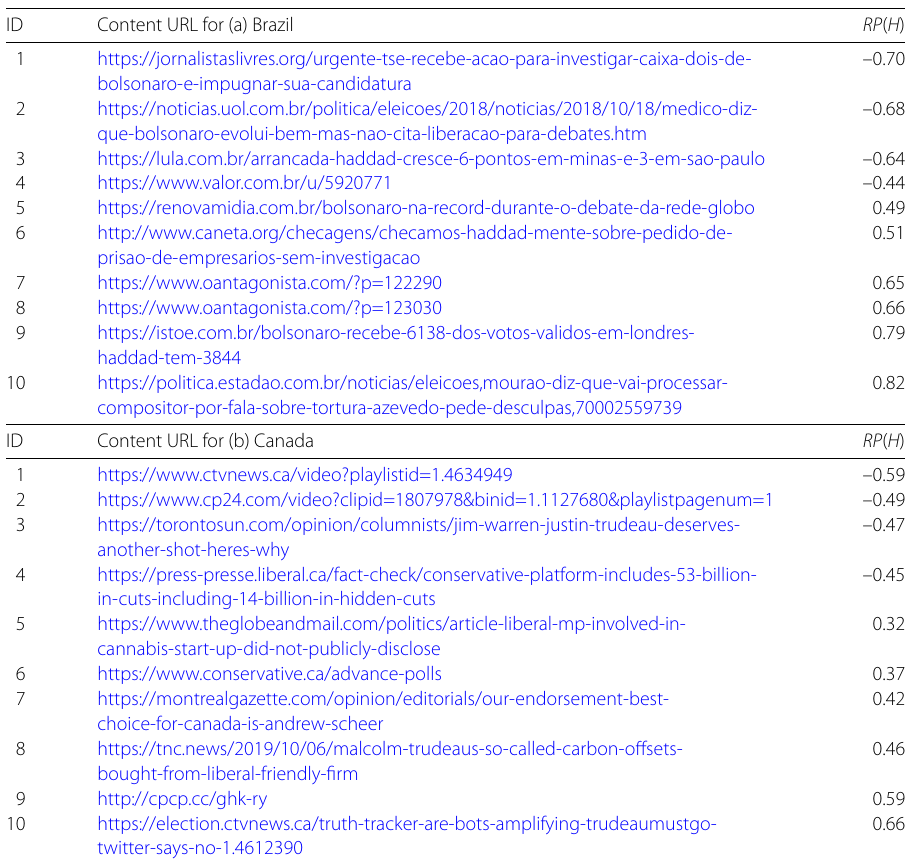
Table 4 Heatmap data references for Fig.